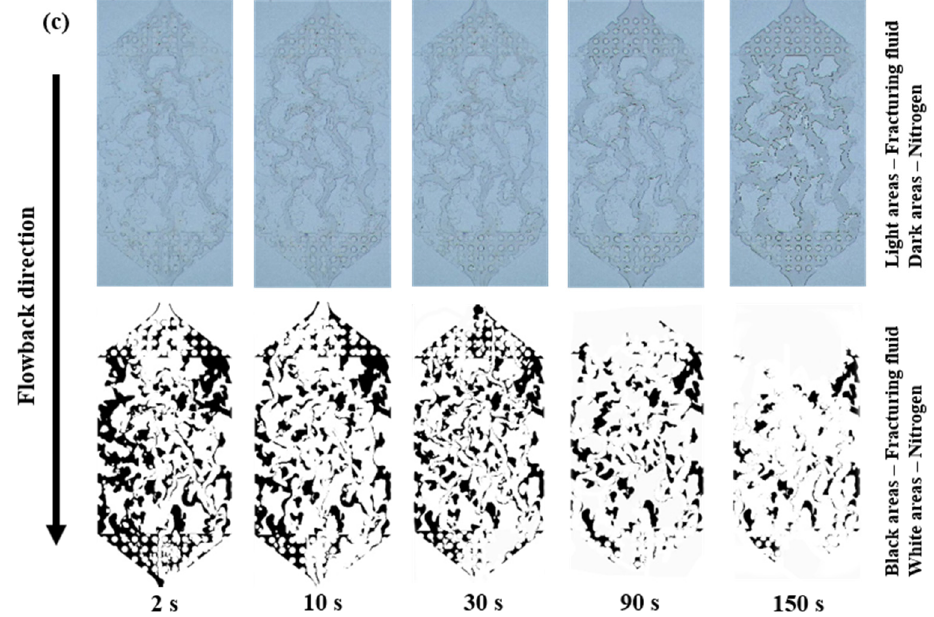
Figure 10. The fracturing fluid (1.2 wt%) flowback process images and binary images ( a ) 0.3 MPa gas drive, ( b ) 0.4 MPa gas drive, ( c ) 0.5 MPa gas drive.